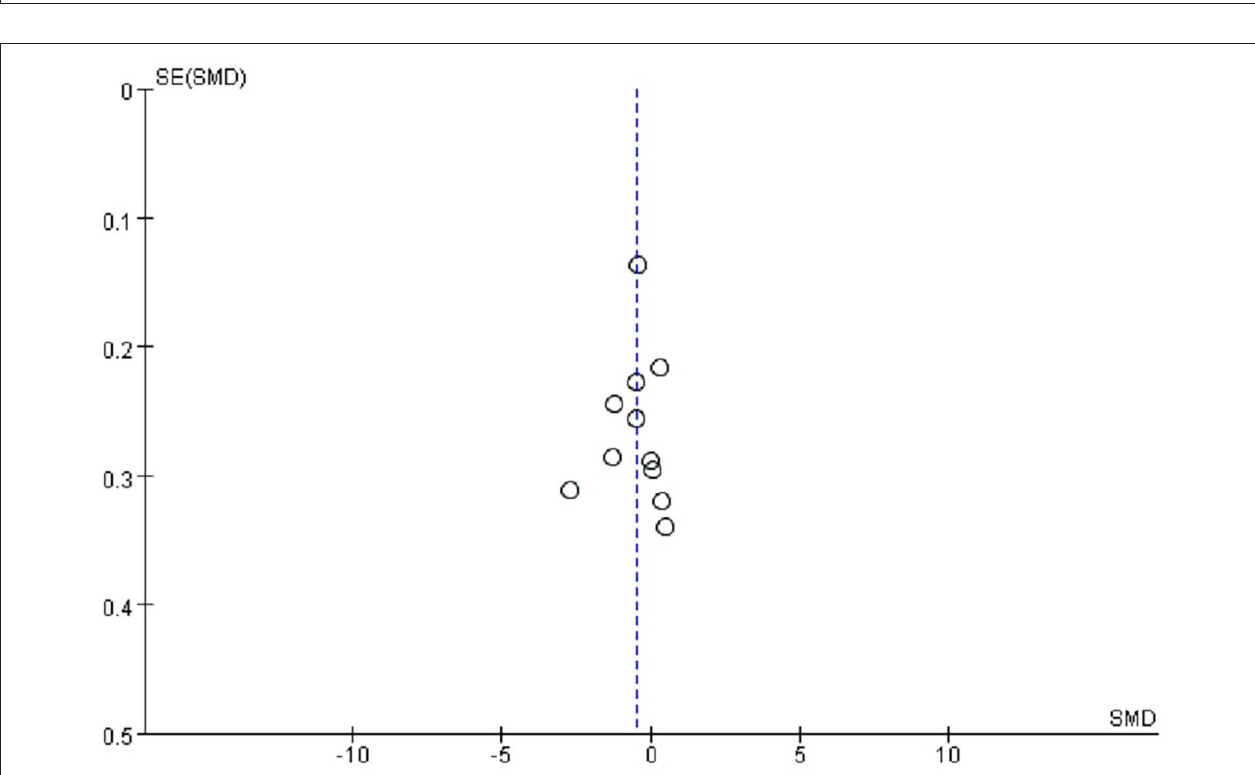
FIGURE 5 | Funnel plot for publication